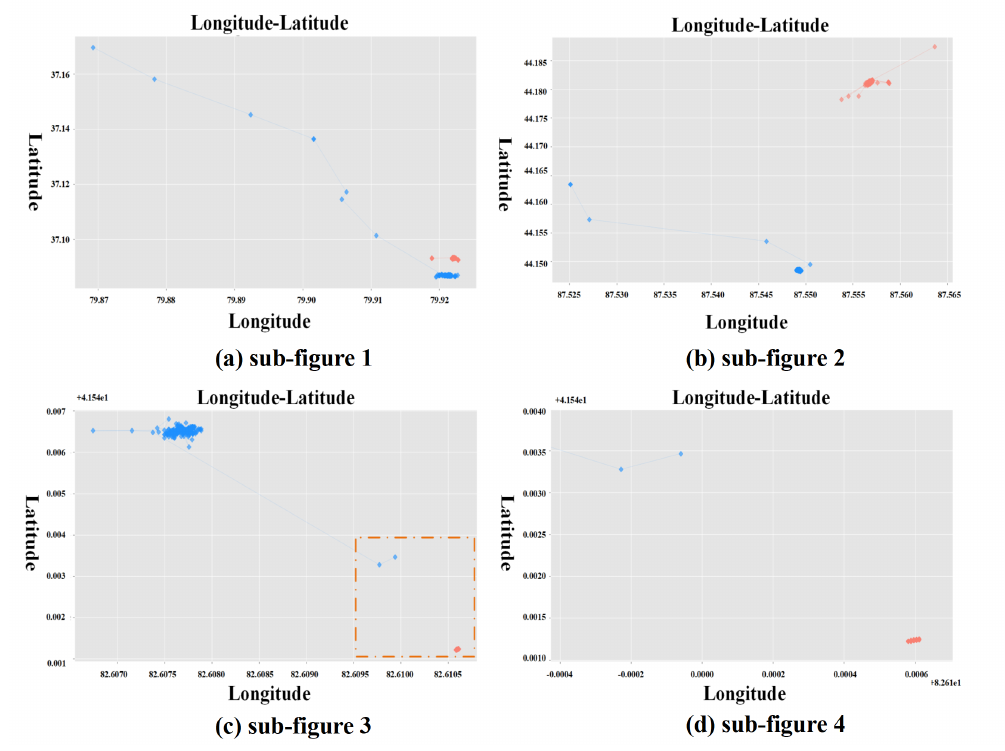
Figure 6. ( a – d ) Brief Contact and